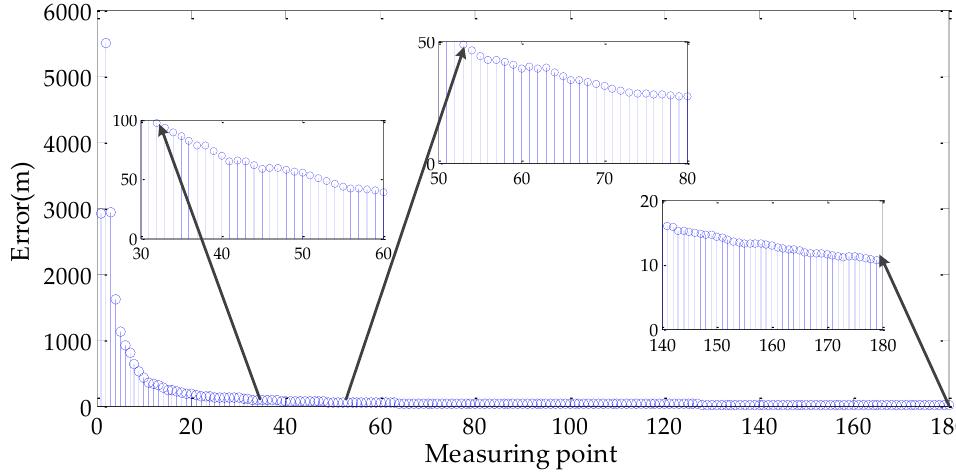
Figure 11. Geo-location error curves of the simulation.